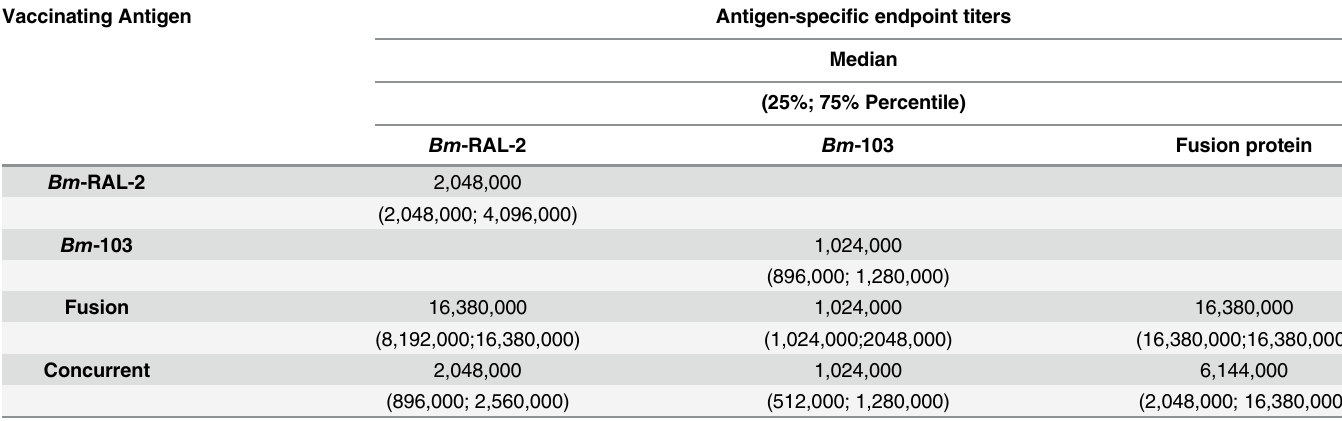
Table 3. IgG endpoint titers in gerbils vaccinated with Bm -RAL-2 and Bm -103 individually, concurrently or as a fusion protein at 2 weeks after 3 rd vaccination (experiments 5 and 9). Vaccinating Antigen